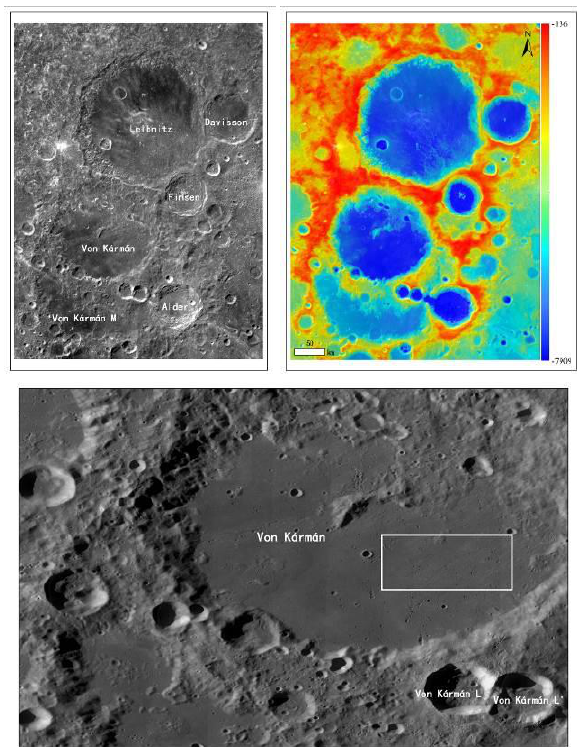
Figure 2. Imagery and topography of Von Kármán crater and surrounding area. Top-left: Chang’e-2 DOM, Top-right: Color coded SLDEM2015, Bottom: LRO WAC mosaic and pre- selected landing site region (white box) of CE-4. The landing site region covers the area (176.4°E~178.8°E, 45.0°S~46.0°S), approximately 51 km  30 km. Huang et al. (2018) estimated the model age of the mare unit of the region to